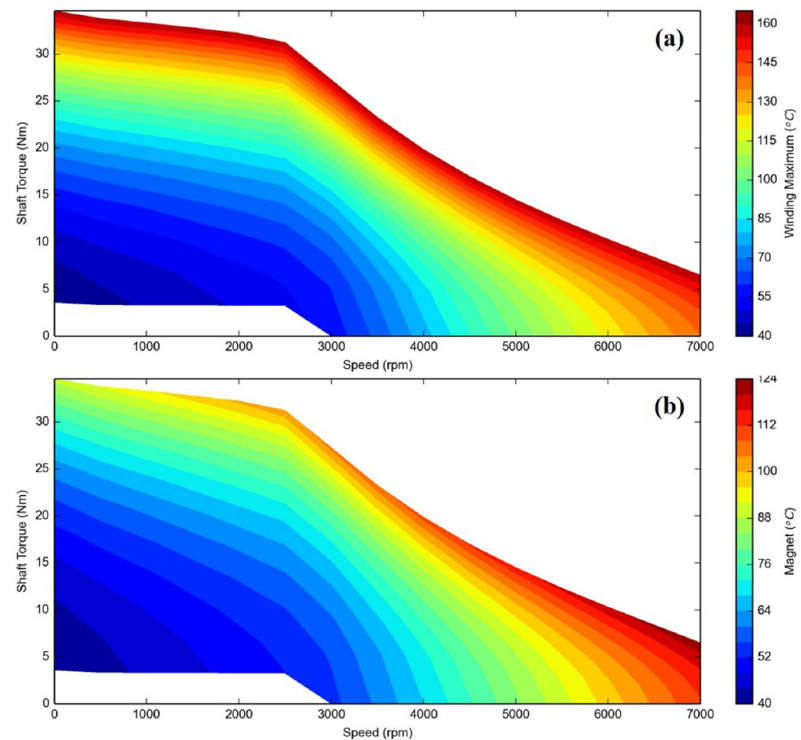
Figure 17. The temperature distribution profiles for ( a ) winding and ( b ) PM of V-shaped IPMSM.